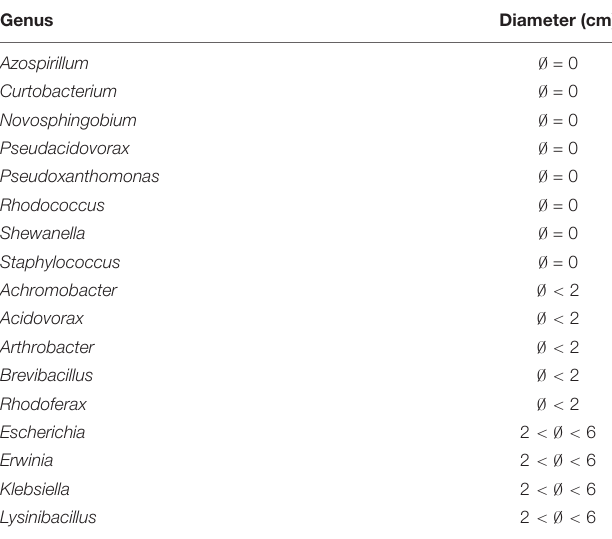
TABLE 1 | Inhibition diameters for genera with only one representing isolate in the